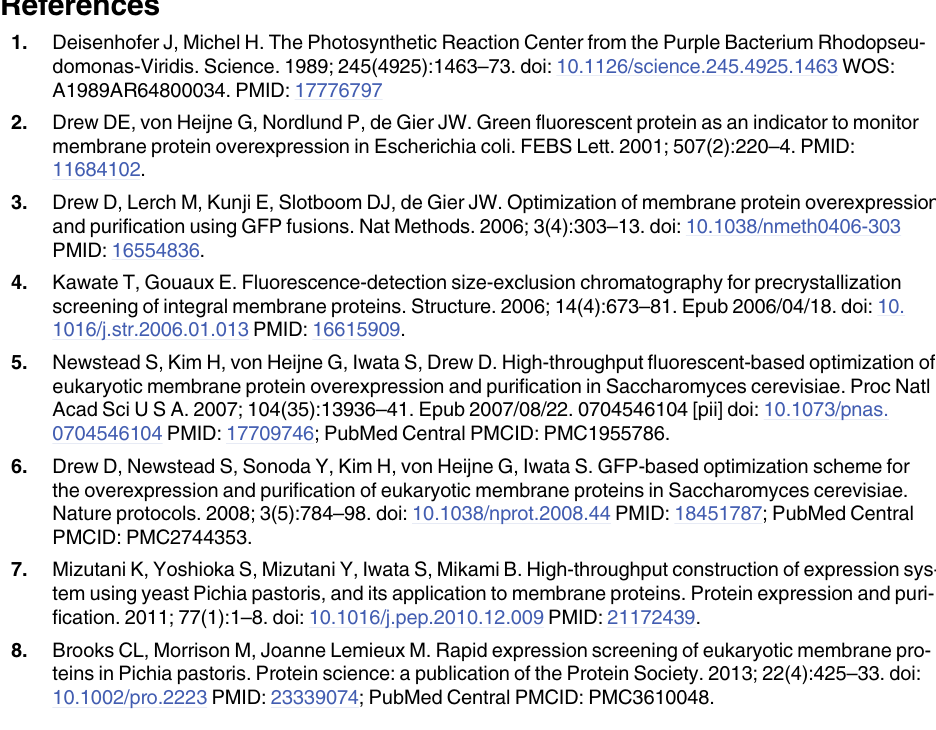
S3 Fig. Comparison of FA-SEC profiles of membranes containing target proteins with or without EGFP. (A) ASBT -EGFP-His8 and ASBT -His8, and (B) HiTehA-EGFP-His8 NM NM and HiTehA-His8 were solubilized in selected detergents (final concentration 1% DDM, 1% DM, 1% NM, 1% LDAO or 2% OG). The red traces are detergent-solubilized membranes con- taining EGFP and the blue traces are those without EGFP. The scales for in each graph are adjusted to be identical. (TIF) S4 Fig. FSEC and FA-SEC profile comparisons of membranes containing target proteins. -EGFP-His8 and (B) HiTehA-EGFP-His8 were solubilized in selected detergents (A) ASBT NM (final concentration 1% DDM, 1% DM, 1% NM, 1% LDAO or 2% OG). The left y axis repre- intensity and the right y axis represents the A intensity. The scales for fluores- sents the F 512 485 cence and absorption profiles in each graph are adjusted to be identical.